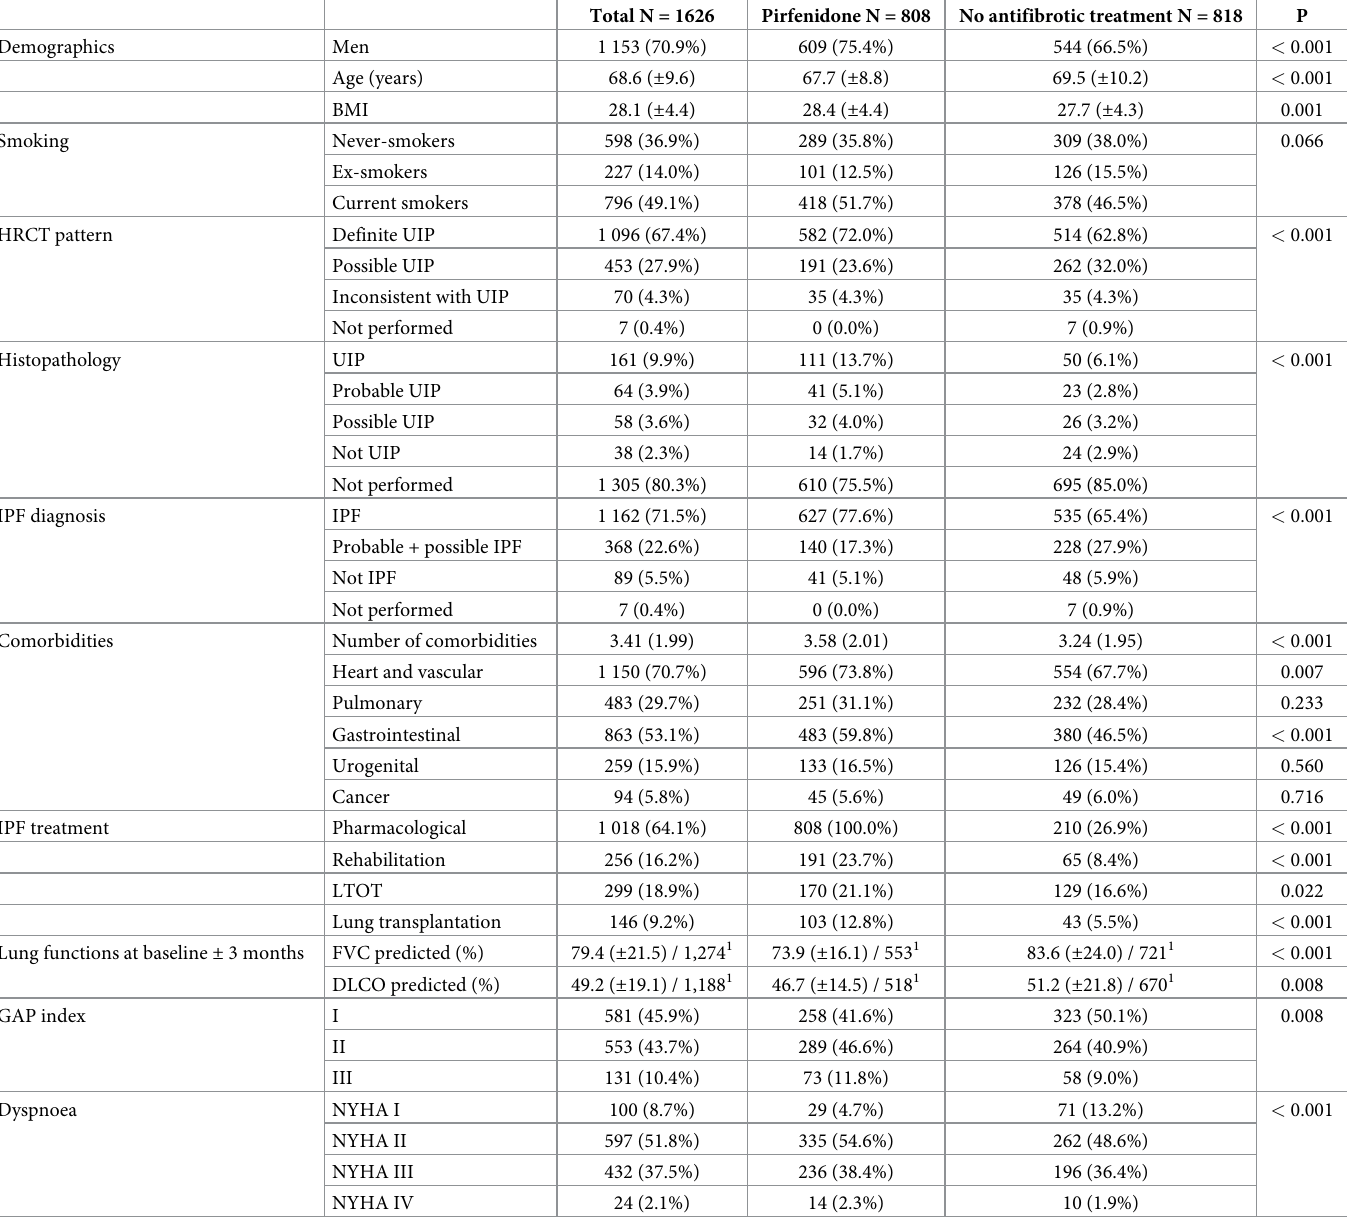
Table 1. Baseline characteristics of patients with pirfenidone and patients on no antifibrotic treatment. Data are given as mean ( ± SD) or N